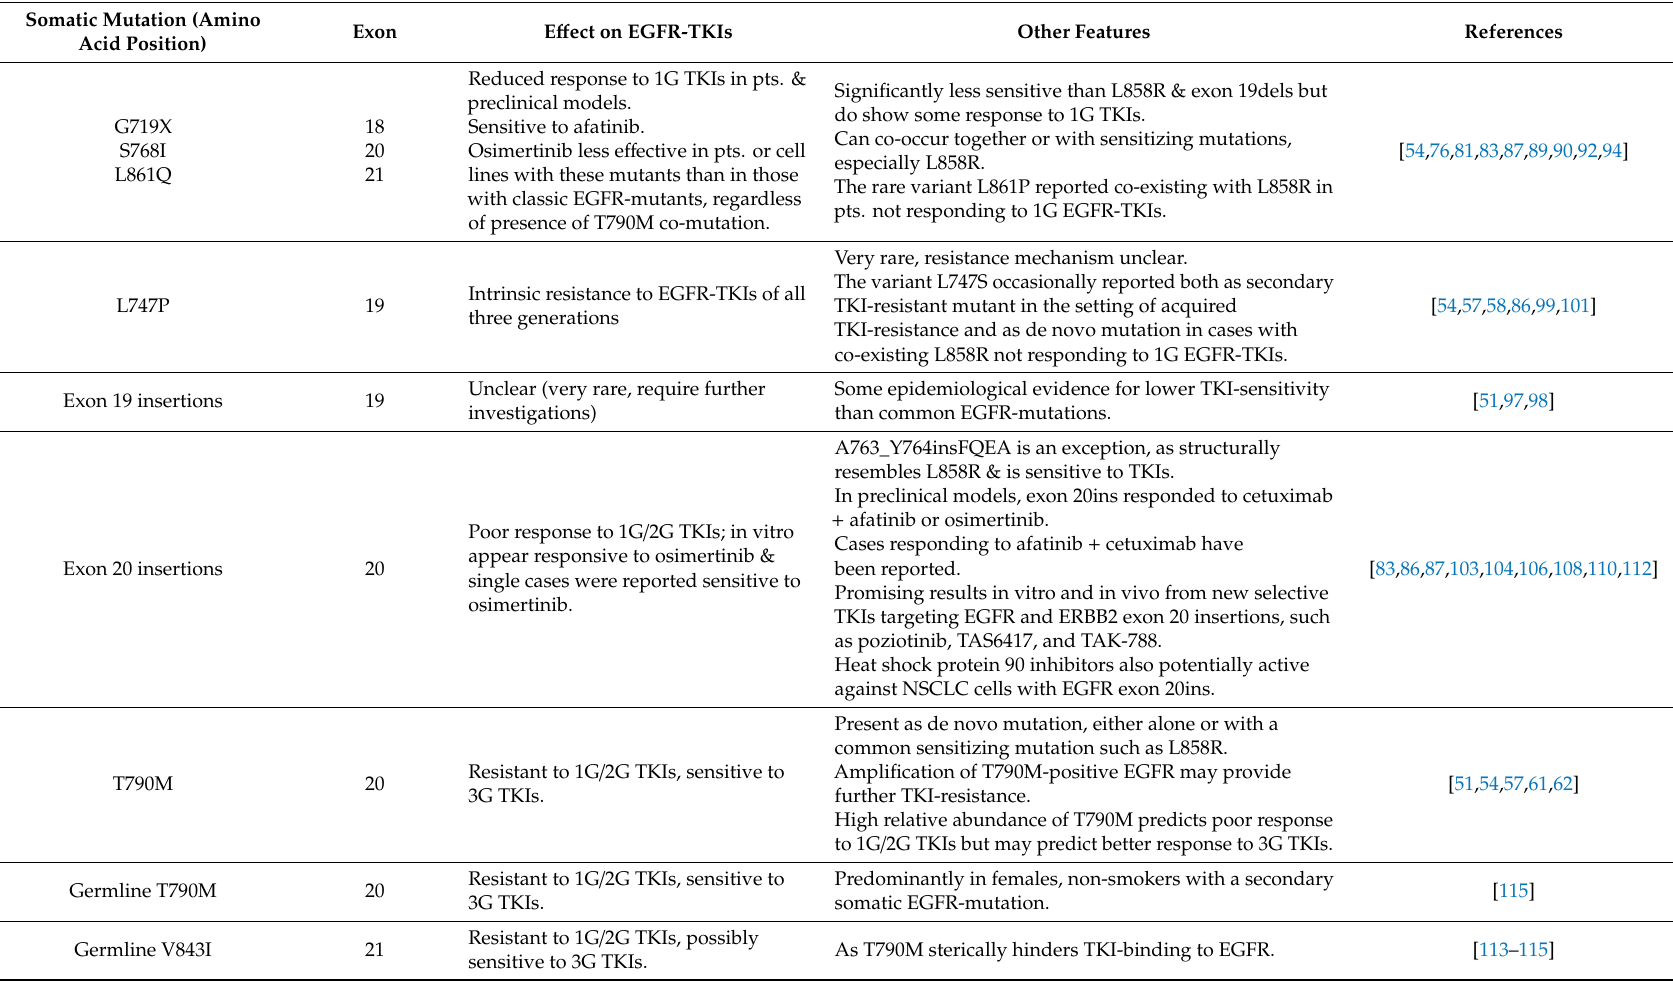
Table 1. EGFR -mutations associated with reduced response or primary resistance to EGFR-TKIs in NSCLC. Somatic Mutation (Amino Exon E ff ect on Acid Position)